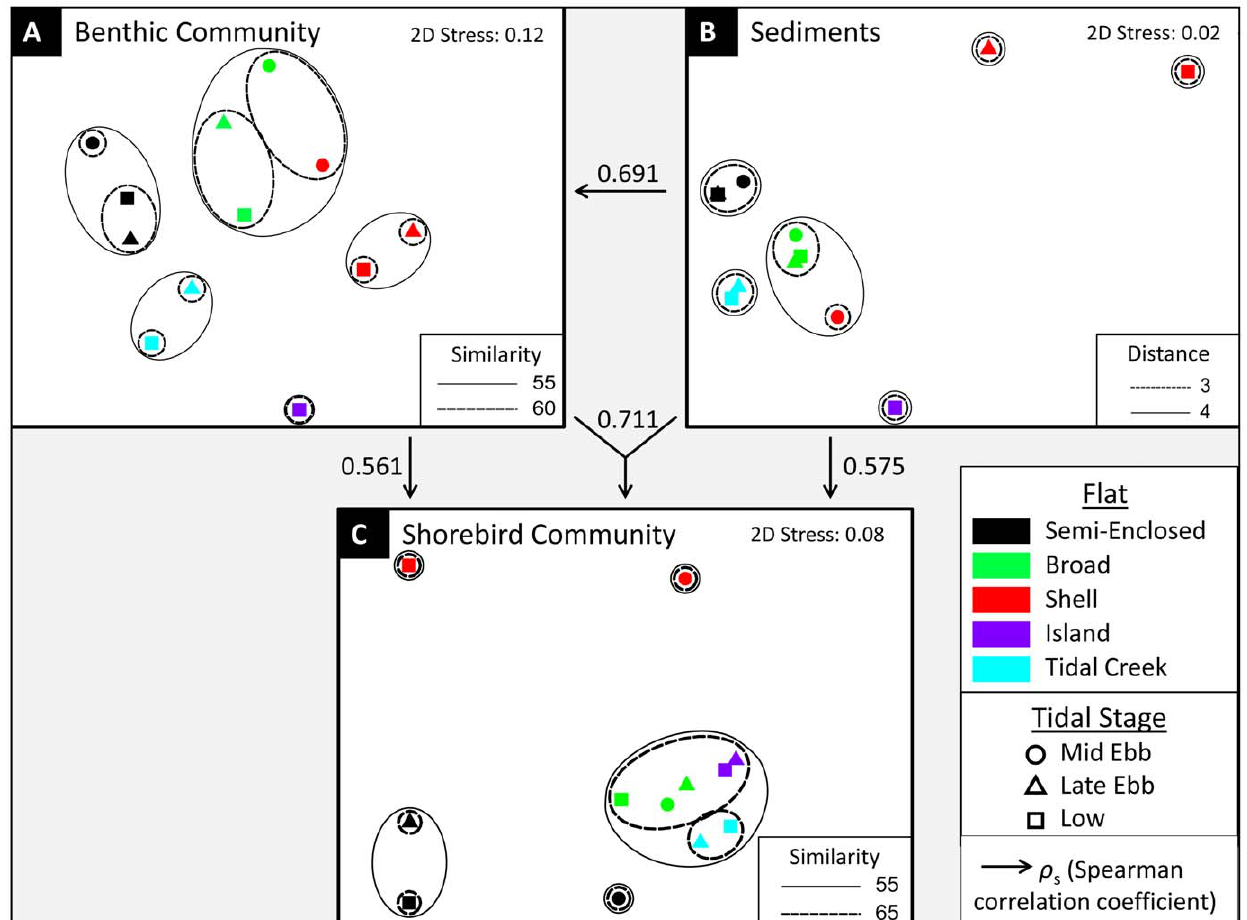
Figure 4. N-MDS ordinations displaying similarities/differences among shorebird and benthic community compositions and sediment grain-size distributions. Results of (A) benthic community composition, (B) sediment grain-size distribution, and (C) shorebird community composition n-MDS ordinations, comparing each combination of flat and tidal stage, with overlays of circles and ovals grouping flats according to cluster analysis results. Similarities given in percent. Grain-size cluster analysis overlay (B) is based on dissimilarity; increasing ‘‘Distance’’ values indicate an increase in dissimilarity among samples. Stress value of 0.12 (A) indicates that the 2-dimensional n-MDS ordination is an adequate and useful representation of sample relationships; stress value of 0.02 (B) indicates that the 2-dimensional n-MDS ordination provides an excellent representation of sample relationships; stress value of 0.08 (C) indicates a good representation. In (B), symbols for Semi-Enclosed Flat at late ebb and low tides are superimposed. In (C), Shell Flat at late ebb tide is not depicted because birds were never observed on the flat at that tidal